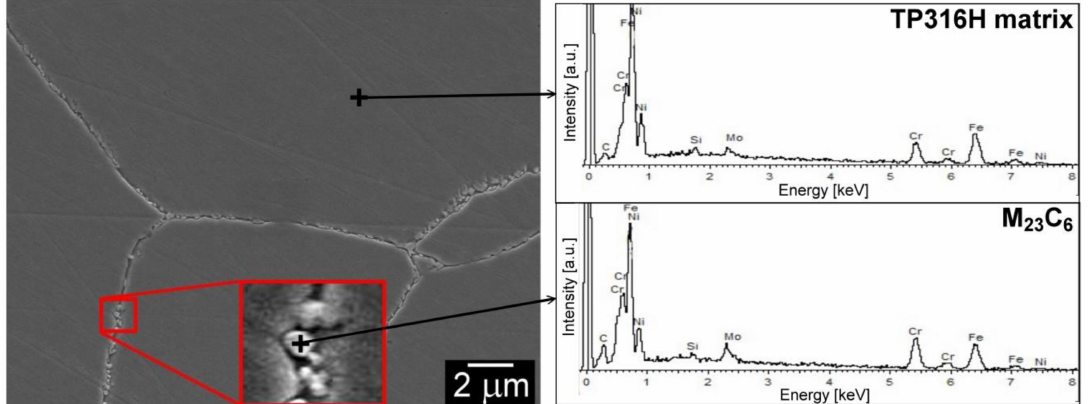
Figure 7. SEM-micrograph of TP316H steel region of the investigated T92/TP316H dissimilar weldment in “QT PWHT” condition and typical EDX-spectra from spot-EDX analyses of the steel matrix and M 23 C 6 secondary phase precipitates.